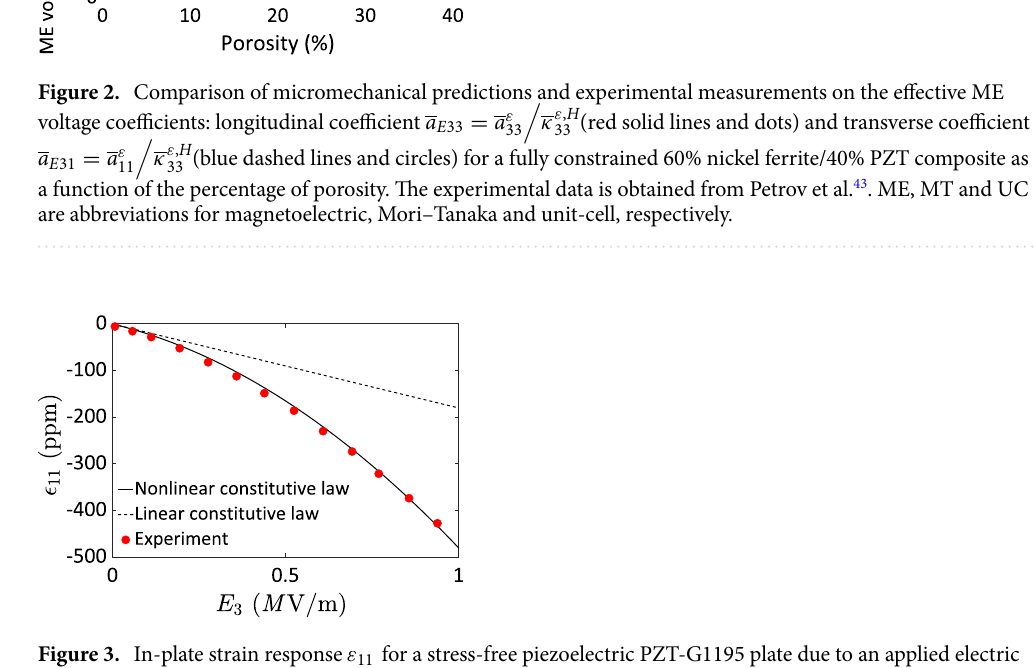
Figure 3. In-plate strain response ε 11 for a stress-free piezoelectric PZT-G1195 plate due to an applied electric field E 3 along the poling direction through the plate thickness (experimental data obtained from Crawley and Anderson 16